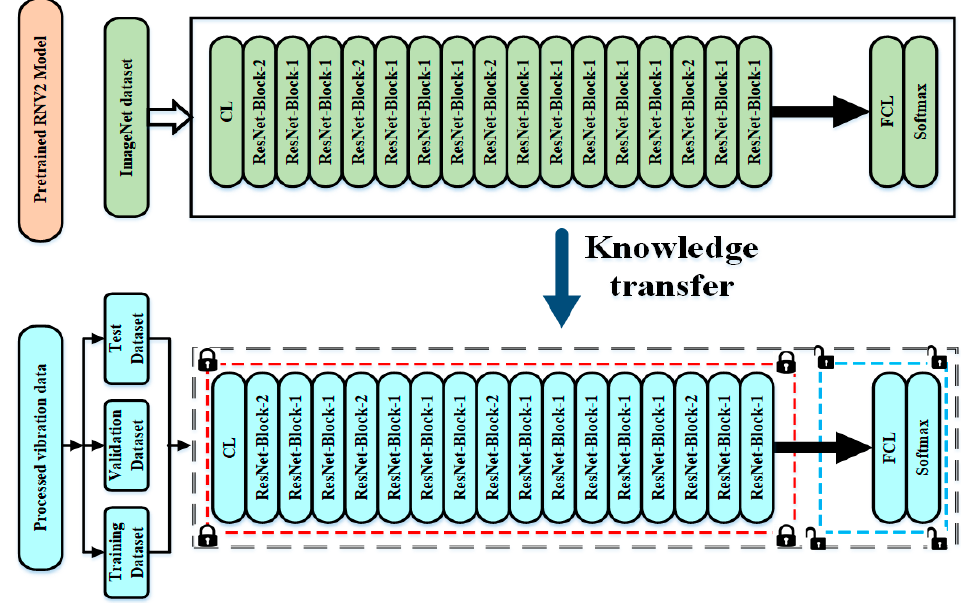
Figure 5. Block diagram of the proposed FD methodology.